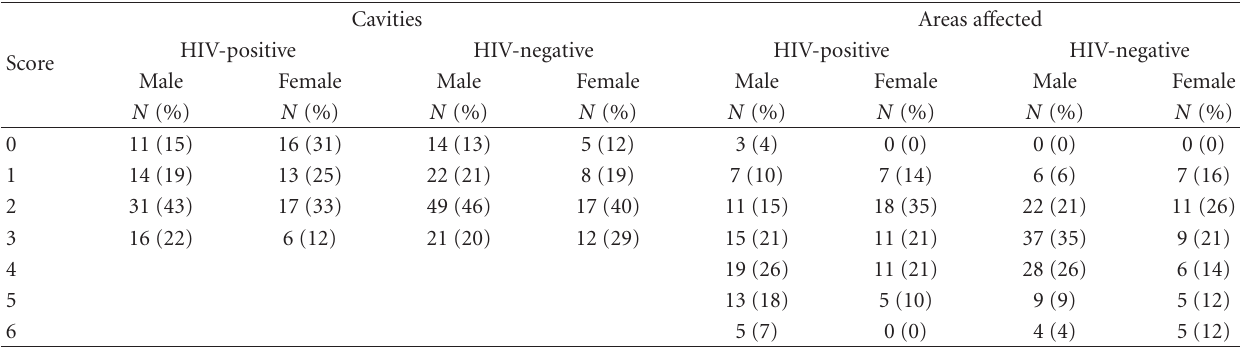
Table 3: Radiological scores of patients with positive culture by gender and HIV status. Cavities Areas a ff